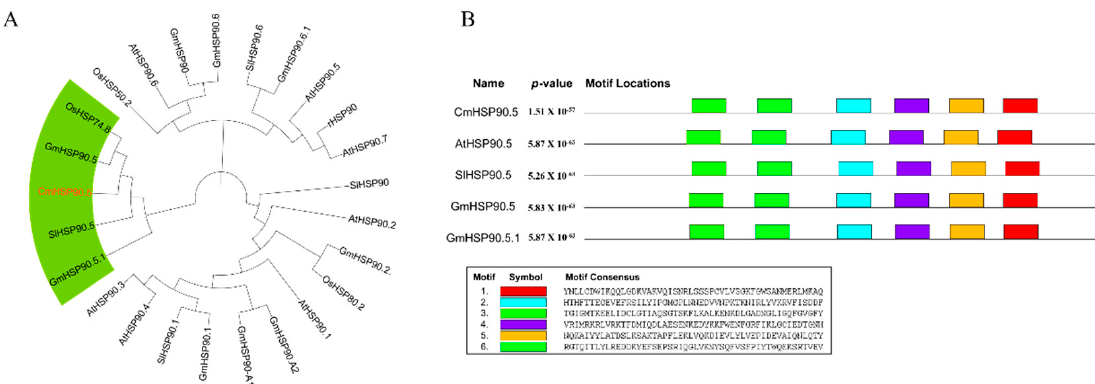
Figure 2. Characterization of the CmHSP90.5 polypeptide sequence. ( A ) A phylogenetic analysis of the CmHSP90.5 amino acid sequence. Phylogenetic tree was constructed using the Neighbor- Joining method with 1000 bootstrap replicates. AtHSP90s of Arabidopsis thaliana were obtained from TAIR (the Arabidopsis Information Resource, https://www.arabidopsis.org/, accessed on 15 July 2021). Other sequences of HSP90 homologs were obtained from GenBank database, and their accession numbers were as follows: Arabidopsis thaliana AtHSP90.1: AT5G52640, AtHSP90.2: AT5G56030, AtHSP90.3: AT5G56010, AtHSP90.4: AT5G56000, AtHSP90.5: AT2G04030, AtHSP90.6: AT3G07770, AtHSP90.7: AT4G24190; GmHSP90-A1: NP_001304616; GmHSP90.6: XP_003545075.4; GmHSP90.5: of HSP90.5 proteins using MEME tools. Conserved motifs are showed in colored